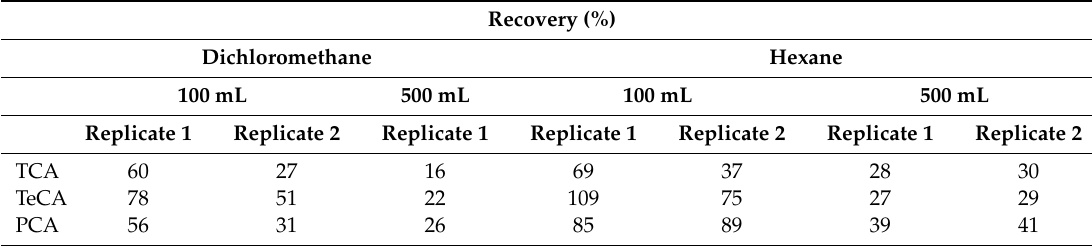
Table 4. Recoveries for dichloromethane and hexane solvents, using fortified macerates of 100 and 500 mL. A flow rate of 20 mL · min − 1 and a drying time of 6 min was used in all cases.